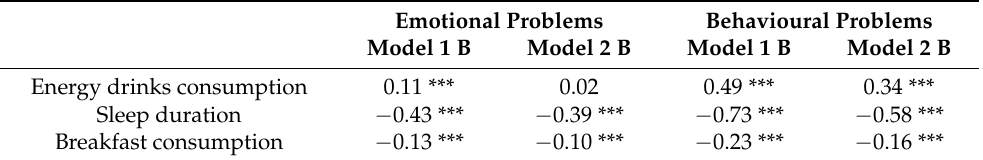
Table 3. Associations between ED, sleep duration and breakfast consumption with emotional and behavioural problems based on linear regression analysis leading to regression coefficients (B) adjusted for gender, age and family affluence (HBSC-study, Slovakia 2018, 11–15 years old, N =